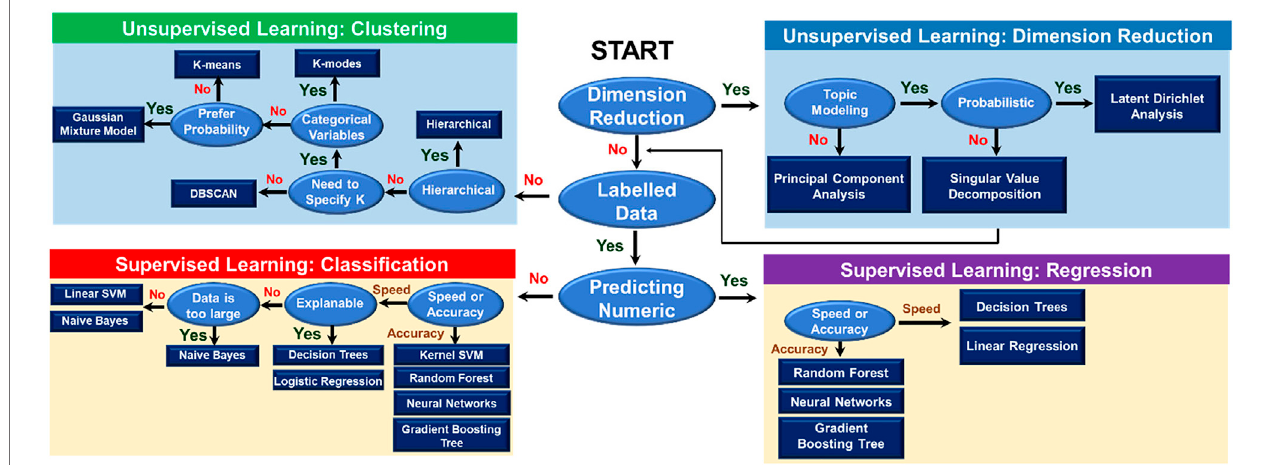
FIGURE3| Overview ofmachinelearningalgorithms.The fl owchartguidesusers intheselectionofanappropriatemachinelearningalgorithm.There aretwomain types of learning, including supervised and unsupervised learning. The selection of relevant algorithms in each type of learning method depends on the purposes of learning, such as clustering, dimension reduction, classi fi cation, or